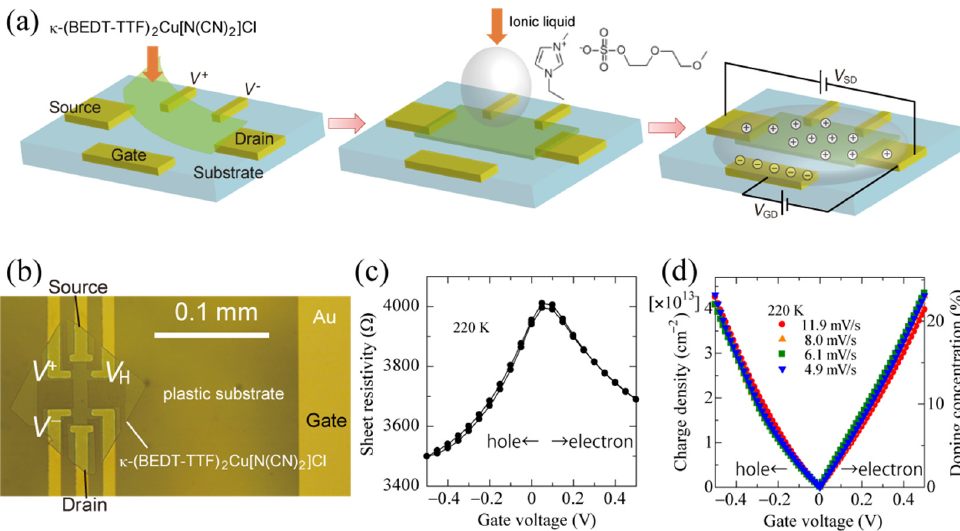
Figure 3. ( a ) Schematic view of device fabrication procedure. ( b ) Optical top view of an EDL transistor device. The κ -Cl crystal is laser-shaped into a Hall bar. ( c ) Gate voltage dependence of sheet resistivity at 220 K. ( d ) Gate-voltage dependence of accumulated charge density and doping concentration.